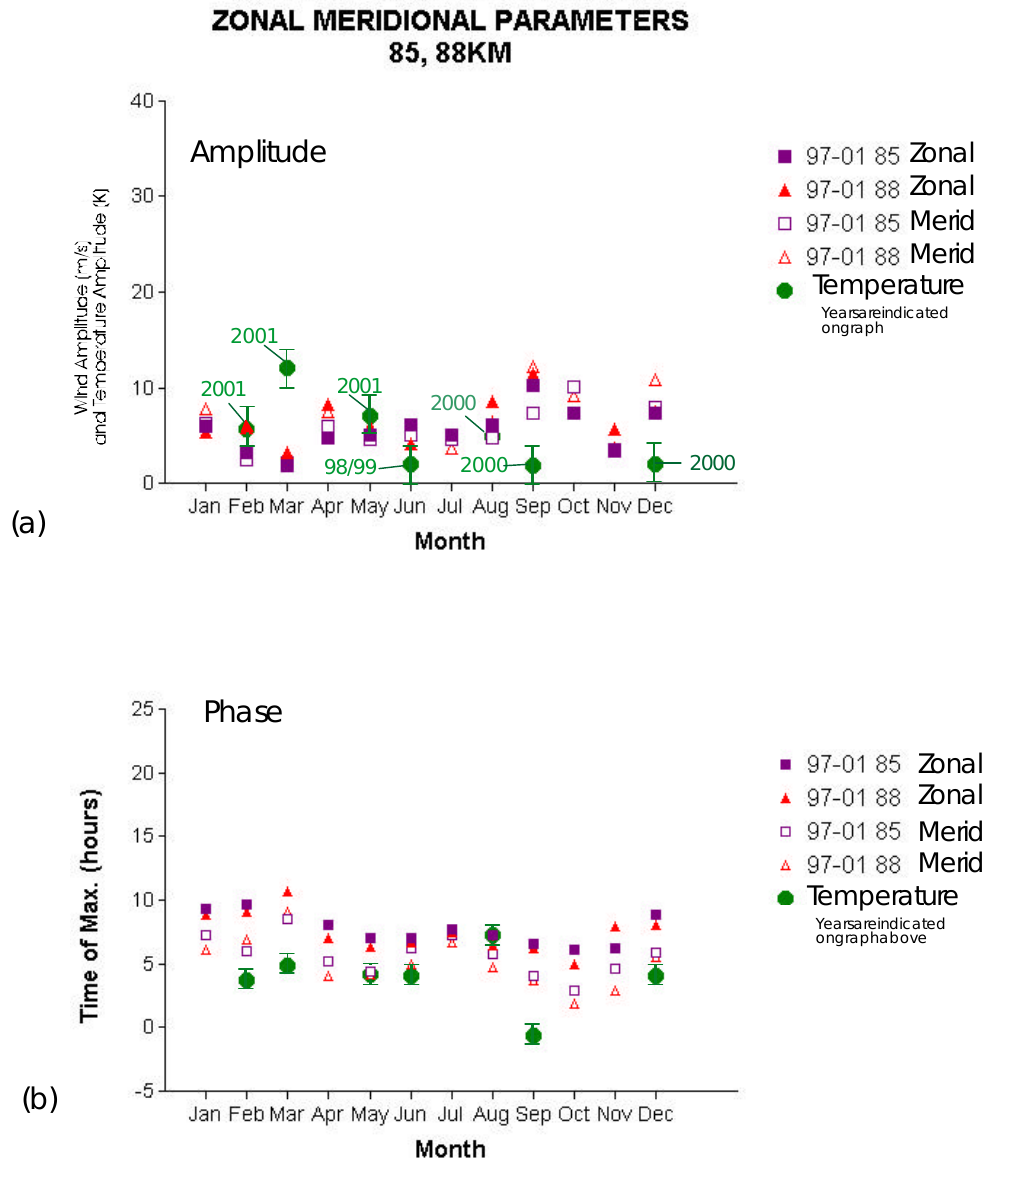
Fig. 12. As for Fig. 11, but for the semidiurnal component for Resolute